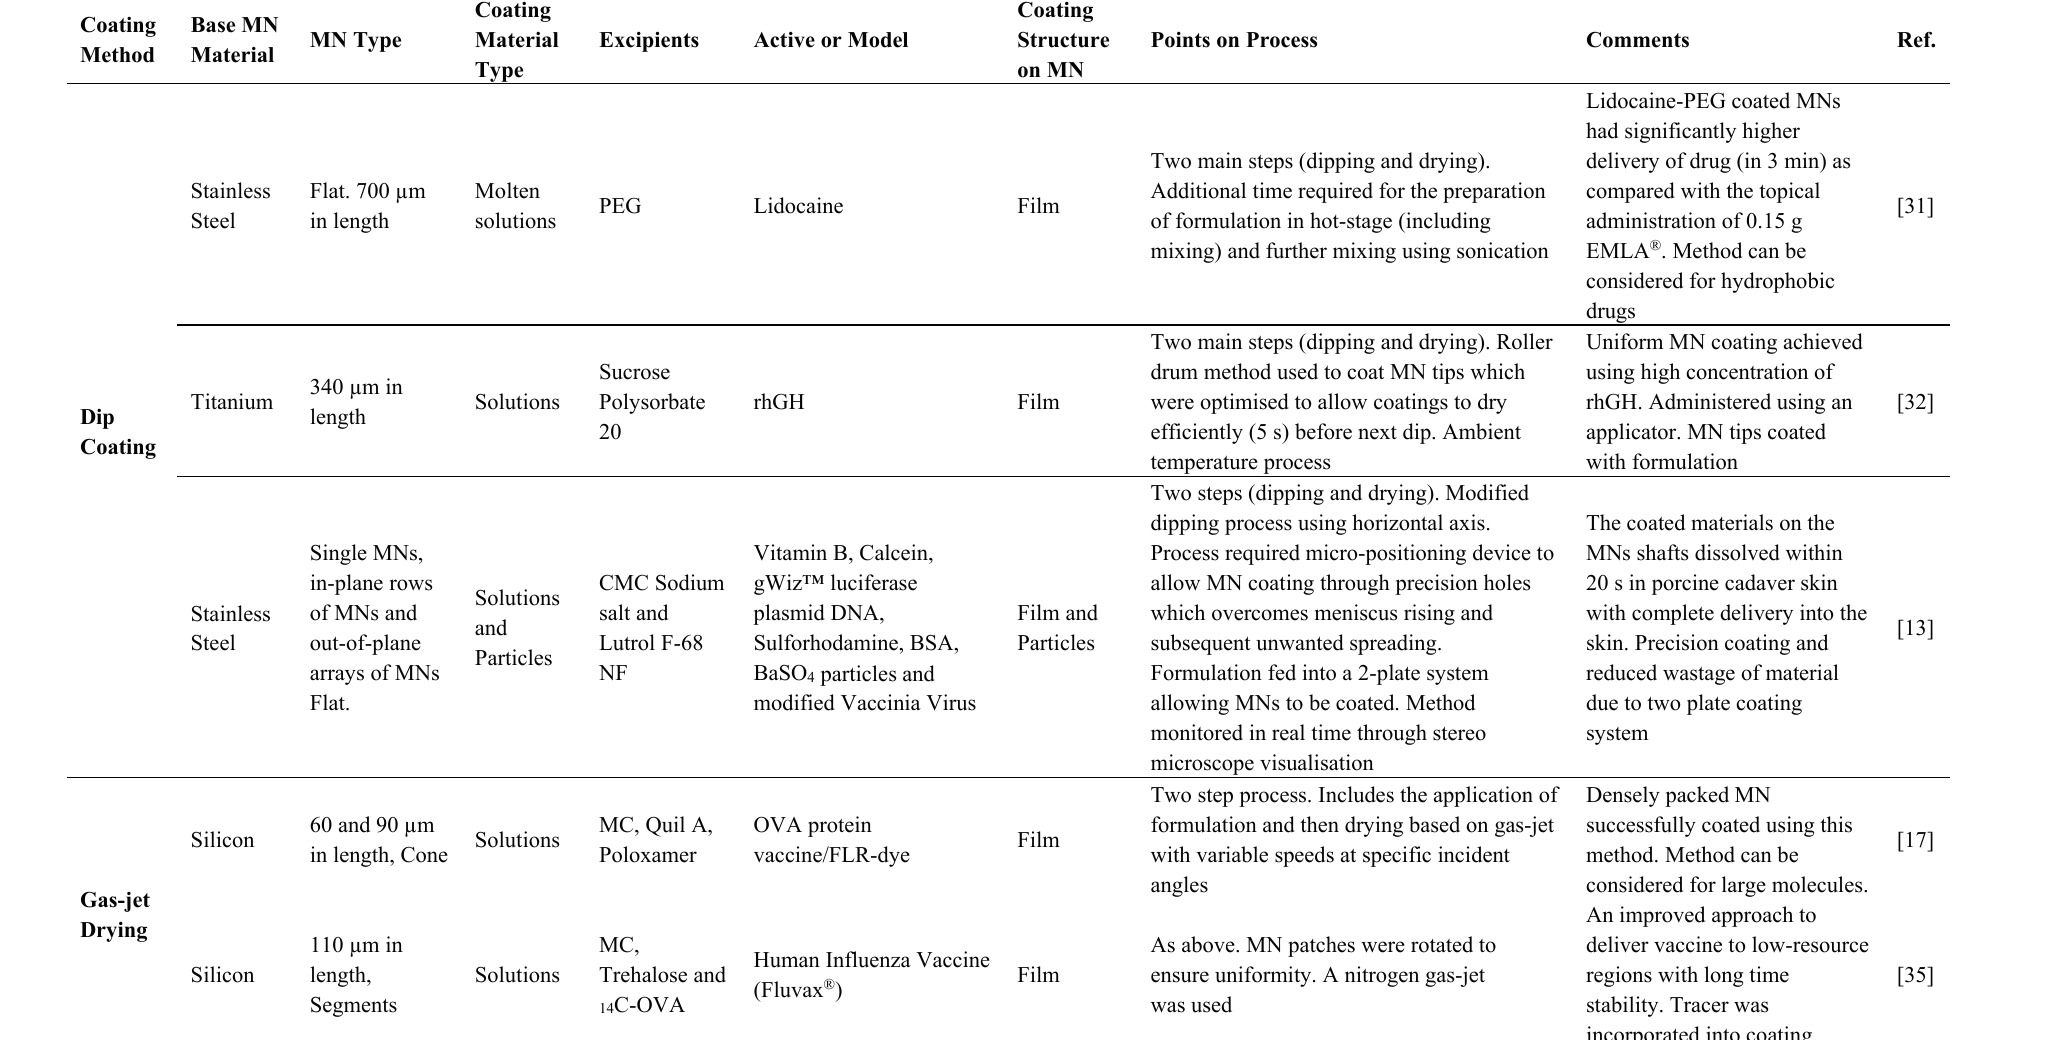
Table 1. Summary of selected MN coating techniques used with research details in selected